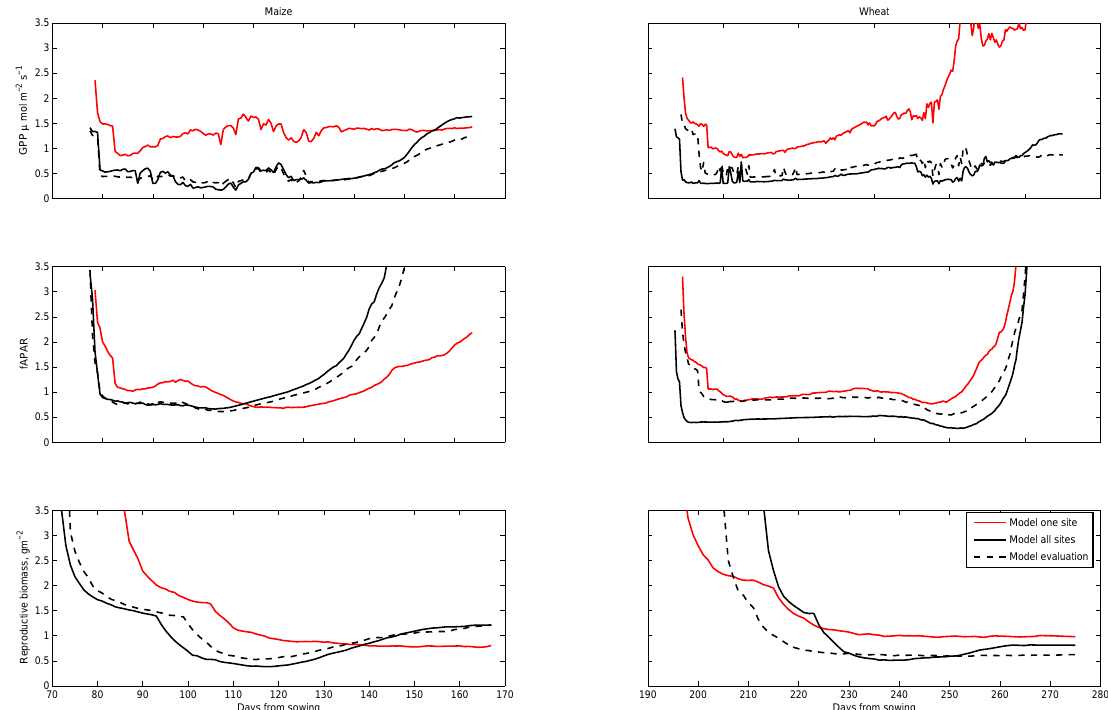
Figure 4. Normalised uncertainty for GPP, fAPAR and yield model predictions at one maize site (US-Ro3) and one wheat site (DE-Gri). Uncertainty is calculated as 95th percentile confidence bounds normalised by the posterior mean for one site, all sites and the evaluation model fit. Neither site has been included in the evaluation fitting.